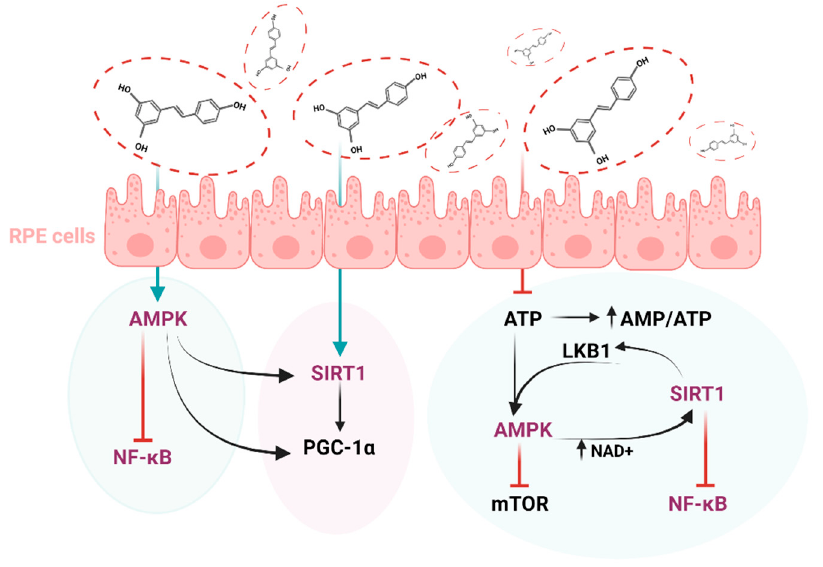
Figure 5. The interplay between key molecules implicated in the management of diabetic retinopa- thy. Abbreviations: AMPK—AMP-activated protein kinase, SIRT1—Sirtuin 1, NF-kB—Nuclear fac- tor-kB, PGC-1 α —Peroxisome proliferator-activated receptor-gamma coactivator, mTOR—Mamma-